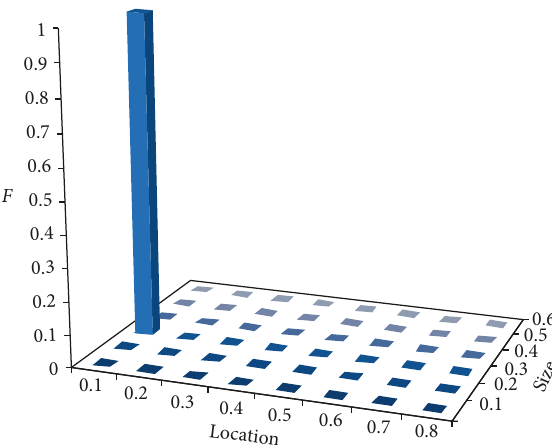
Figure 8: Nondimensional plot ( η locations and sizes illustrated for an Euler–Bernoulli and St. Venant torsion [1386] beam.